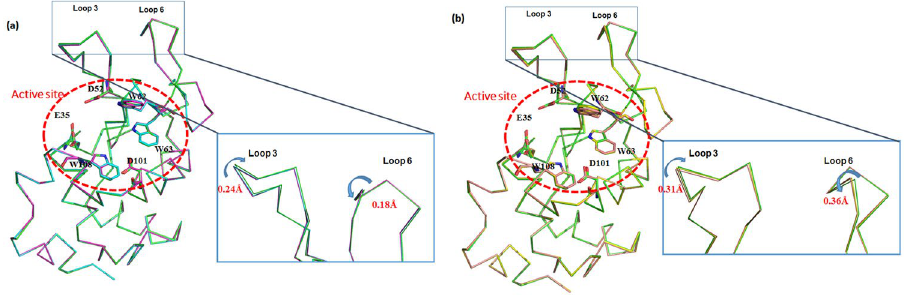
Figure 4. Backbone conformational changes of lysozyme. ( a ) The structural differences between control (magenta) and treatment (cyan: 8 min and green: 12 min) of Air-DBD. ( b ) The structural differences between control (salmon) and treatment (yellow: 8 min and green: 12 min) of N 2 -APPJ.